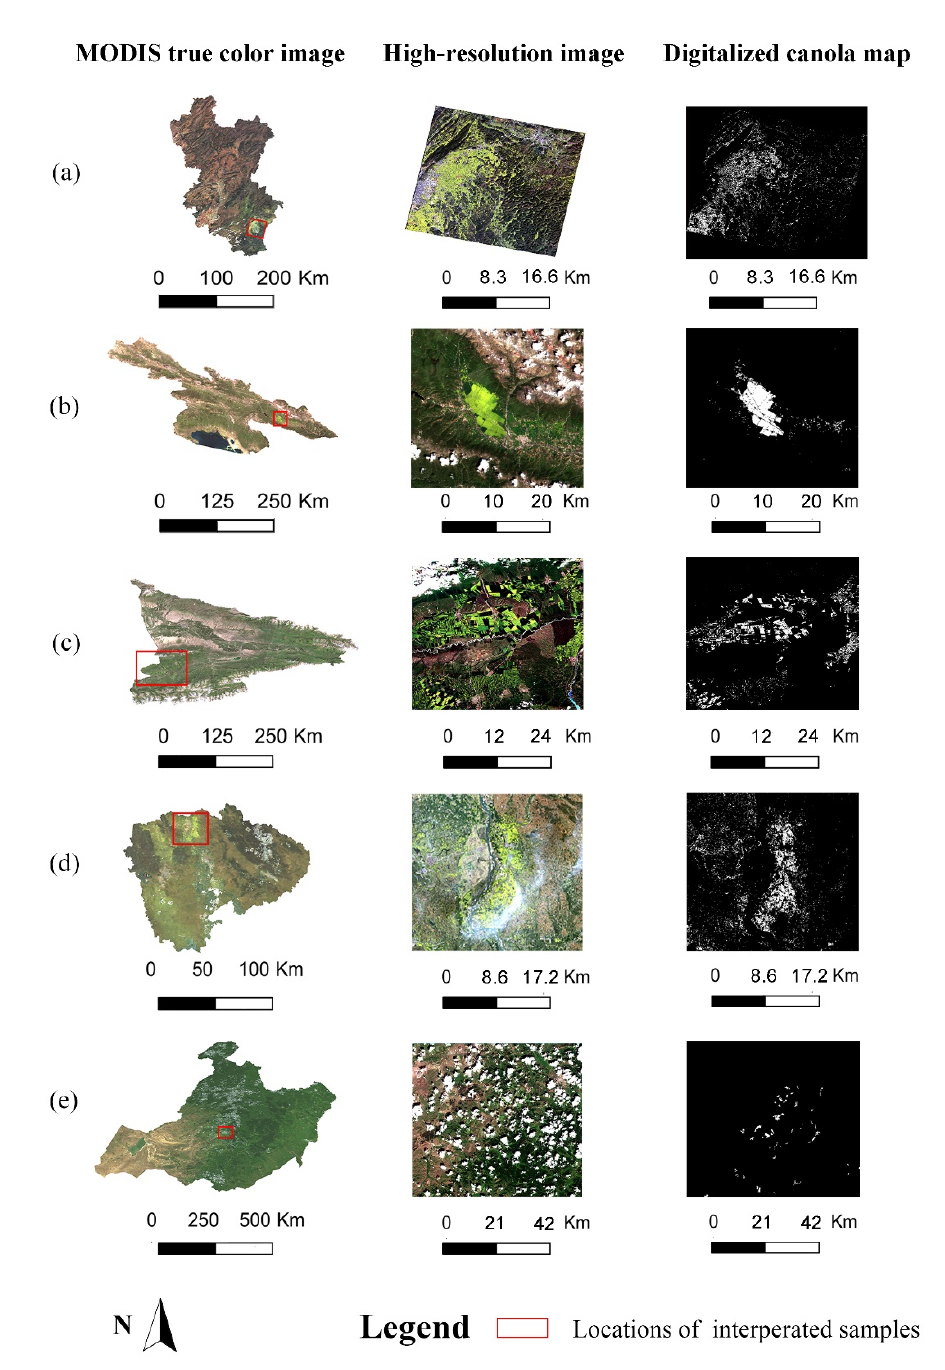
Figure 2. MODIS true color images of the study areas, high-resolution images and the canola distribution interpreted from High-resolution images. ( a ) Qujing, ( b ) Haibei, ( c ) Yili, ( d ) Jingmen, ( e ) Hulun Buir. Three yellowness indices were calculated from MOD09GA and MYD09GA time-series as